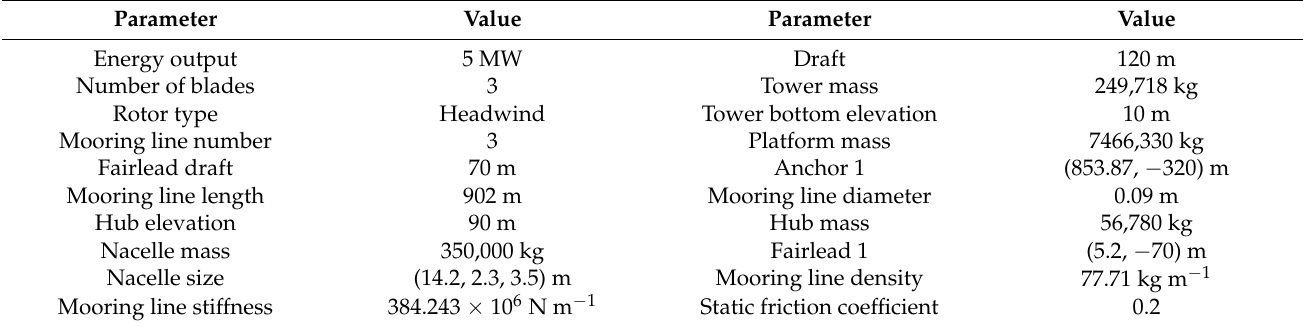
Table 1. Key structural parameters of OC3-Hywind spar-type 5 MW offshore wind turbine.